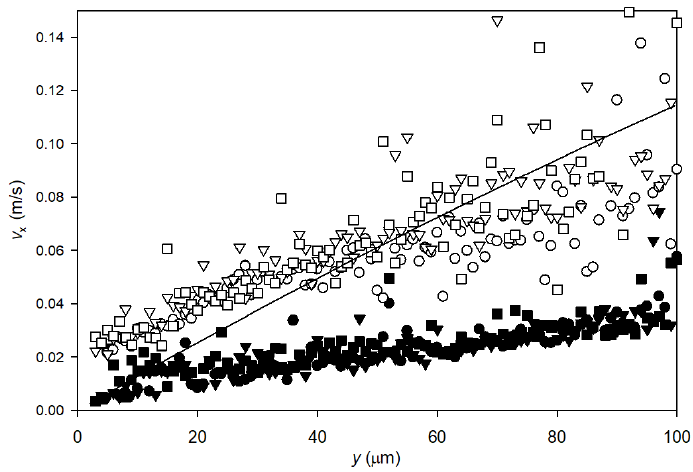
Figure 7. Longitudinal velocity of lowly charged model particles along the membrane surface plotted against particle distance from the membrane surface. Points (cid:4) , • and (cid:72) represent particles recorded at a crossflow velocity of 0.13 m / s while (cid:3) , and ∇ are particles recorded at 0.33 m / s crossflow velocity. For each crossflow velocity, three recordings were conducted during membrane filtration at TMP = 2 bar. The line represents modelled water velocities along the membrane fiber at 0.33 m / s crossflow velocity and 2 bar TMP using COMSOL.